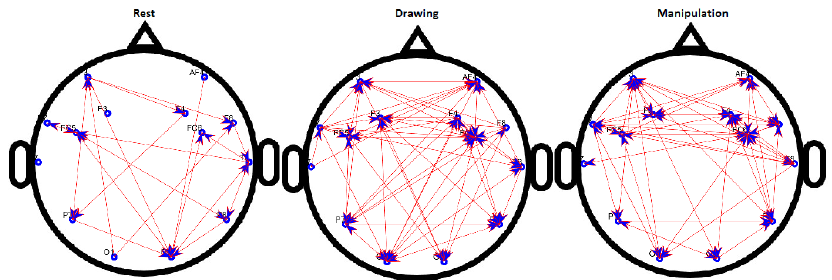
Figure 9. Binary directed functional brain network during rest, drawing and manipulation states of expert user.